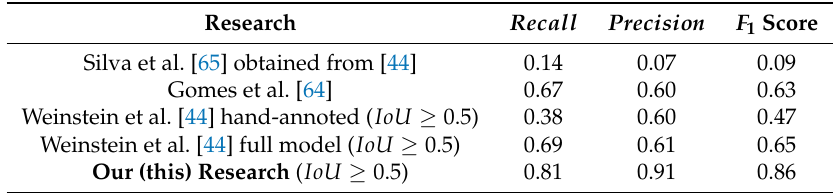
Table 9. Average values of evaluation metrics Recall , Precision , and F 1 score of recent research that also conducted the TCDD. Research Recall Precision F 1 Score Silva et al. [65] obtained from [44] 0.14 0.07 0.09 Gomes et al. [64] 0.67 0.60 0.63 Weinstein et al. [44] hand-annoted ( IoU ≥ 0.5)